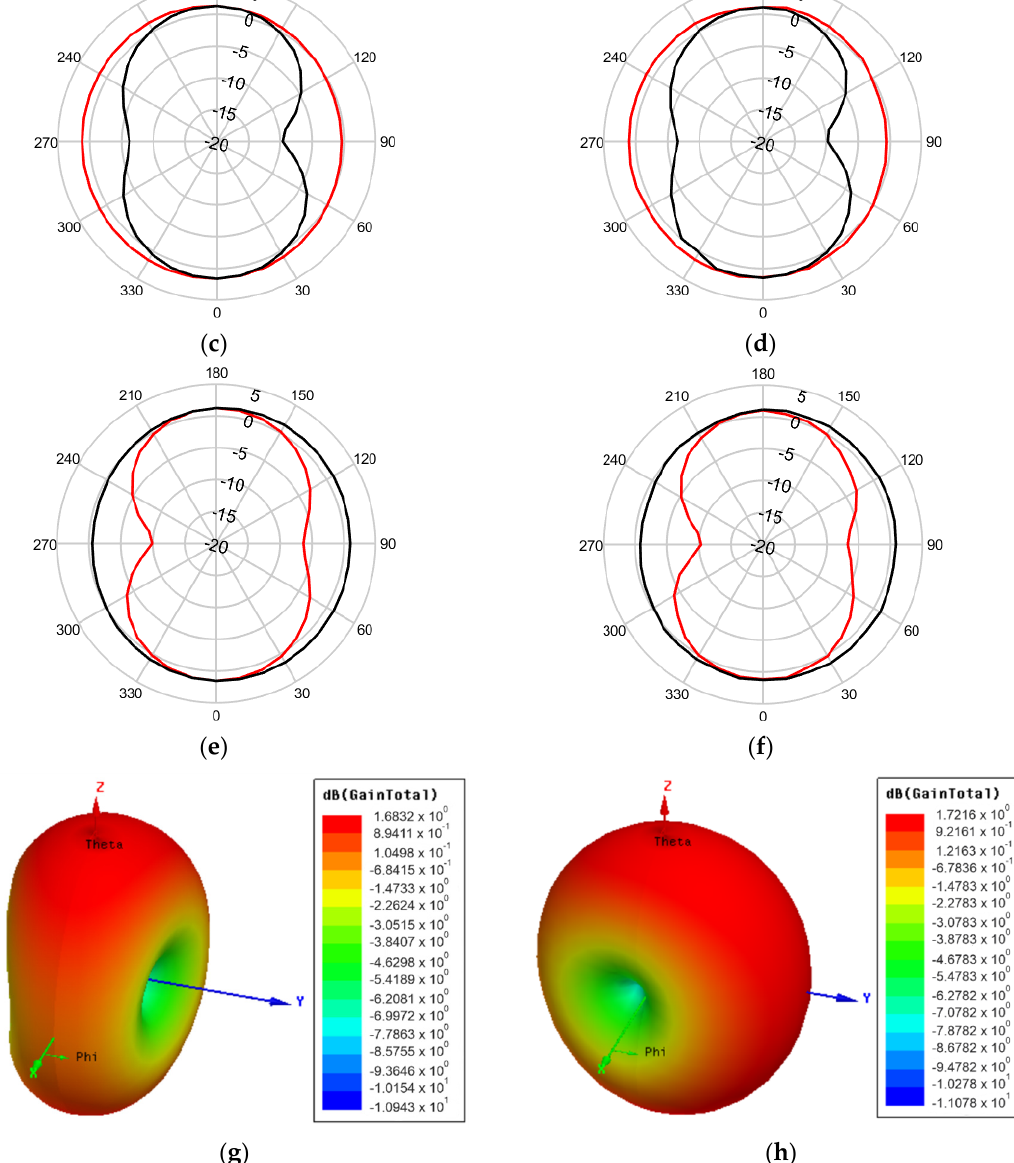
Figure 9. Proposed MIMO antenna simulated and measured parameters. ( a ) Measurement setup. ( b ) Measured S-parameters. Port 1 results: ( c ) Simulated and ( d ) measured 2-D radiation patterns at 3.5 GHz and 𝜙 = 0° (x-z plane) in red color, and 𝜙 = 90° (y-z plane) in black color. Port 2 results: ( e ) Simulated and ( f ) measured 2-D radiation patterns at 3.5 GHz and 𝜙 = 0° (x-z plane) in red color, and 𝜙 = 90° (y-z plane) in black color. Simulated 3-D radiation patterns results at 3.5 GHz: ( g ) Port